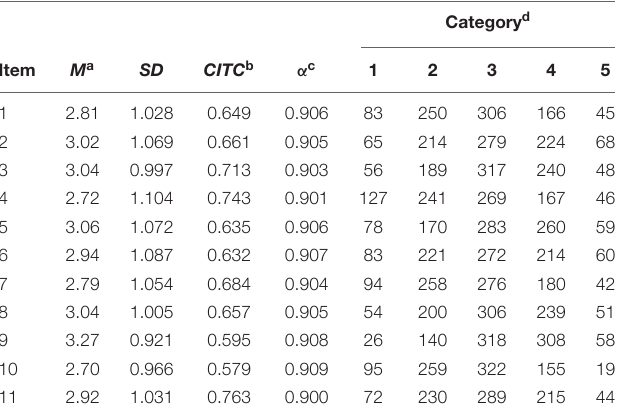
TABLE 6 | Classical item analysis of the self-regulation scale ( α = 0.91, CI 95 = 0.90, 0.92).